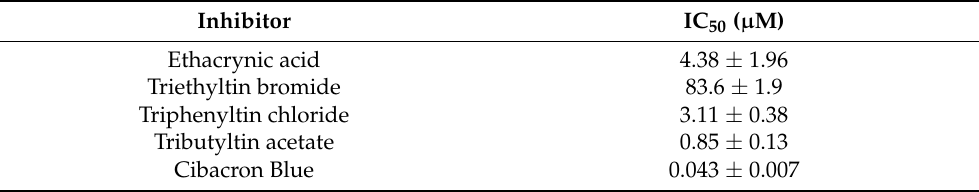
Figure 4. Inhibition of dog GST P1-1 with alternative compounds: ( A ) triphenyltin chloride, ( B ) Cibacron Blue, ( C ) triethyltin bromide, ( D ) Ethacrynic acid, and ( E ) tributyltin acetate. Remaining activity with the substrate benzyl isothiocyanate as compared with uninhibited enzyme plotted versus inhibitor concentration. Curves were fitted to the experimental data by nonlinear regression in GraphPad. Table 2. Effect of enzyme inhibitors on dog GST